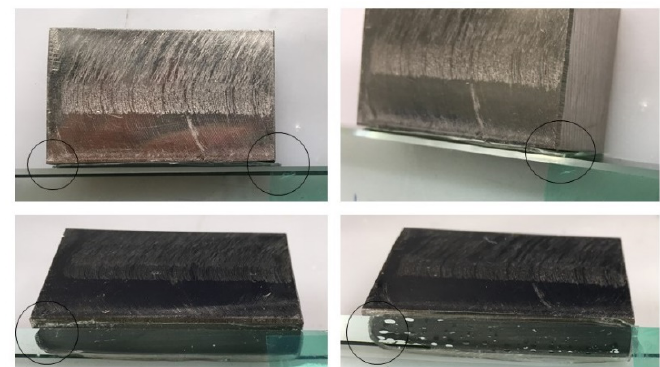
Fig. 18 Pictures after fabrication - weak